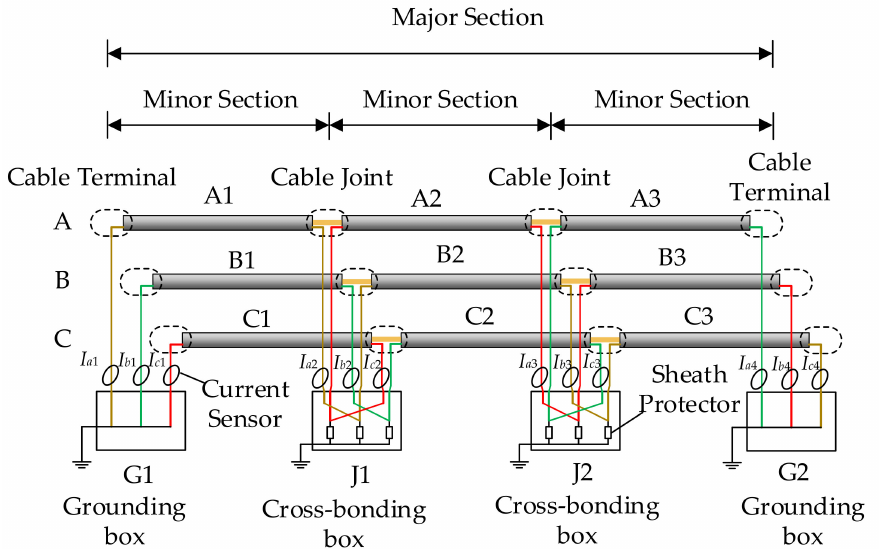
Figure 4. The schematic diagram of a typical high voltage (HV) cross-bonded cable circuit (The yellow line represents phase A, the green line represents phase B, the red line represents phase C. A1–C3 are the labels of different cable sections).